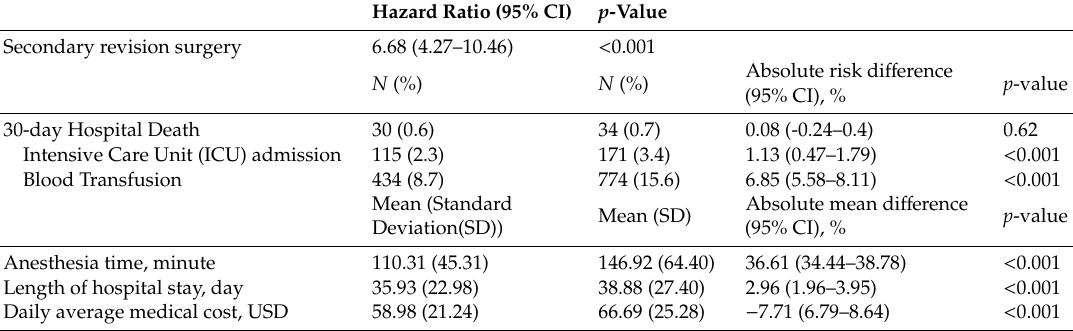
Table 3. Thirty-day mortality and other clinical outcomes between propensity score matched